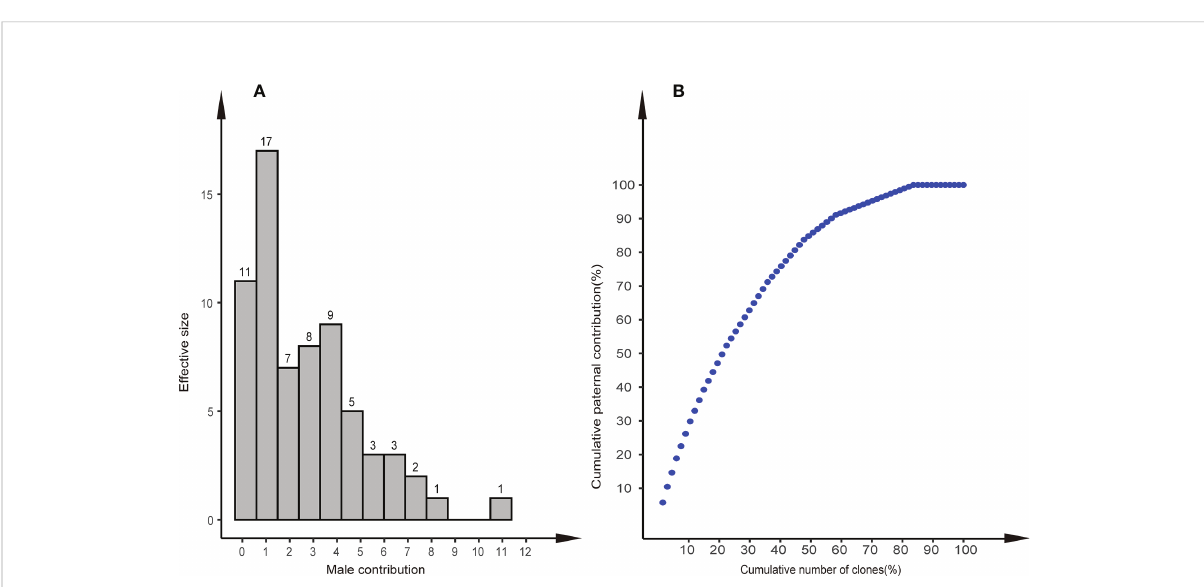
FIGURE 4 Distribution of paternal contributions and cumulative paternal contribution. (A) Distribution of paternal contributions of the 58 identi fi ed paternal clones in the Chinese fi r clonal seed orchard. (B) Relationship between the cumulative number of clones (%) and cumulative paternal contribution (%) in the seed